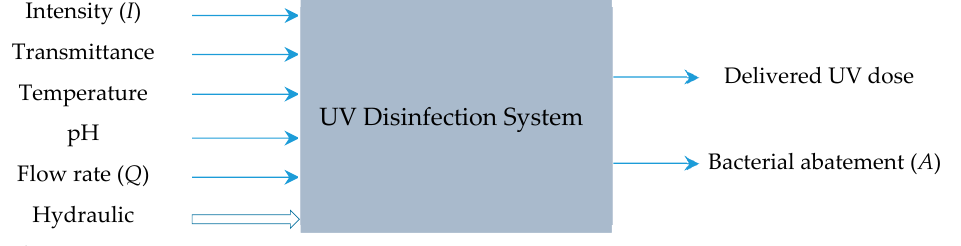
Figure 2. Input and output variables of the UV disinfection system’ model.